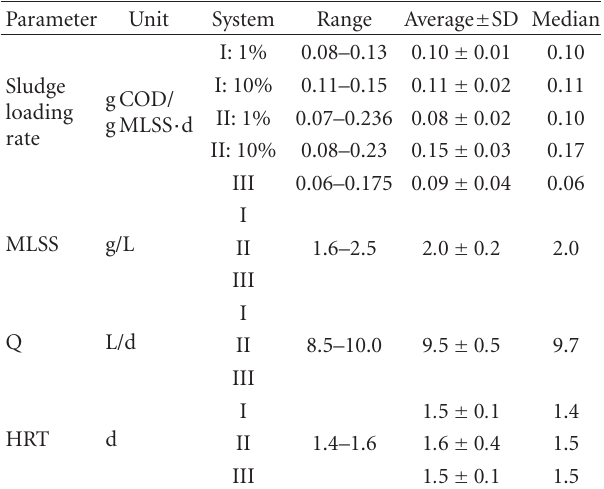
Table 2: Operational parameters of activated sludge systems I, II, and